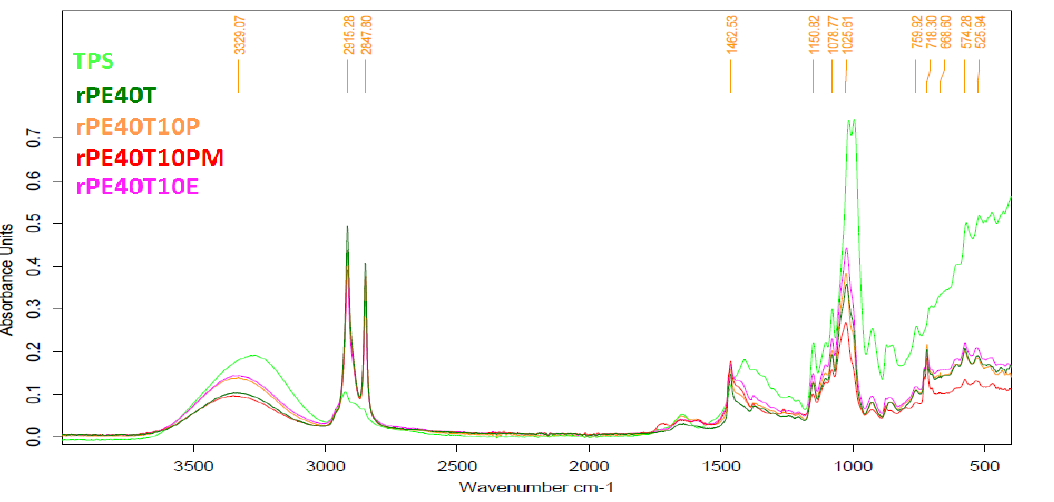
Figure 6: FTIR Spectrums of prepared r-LDPE/TPS based